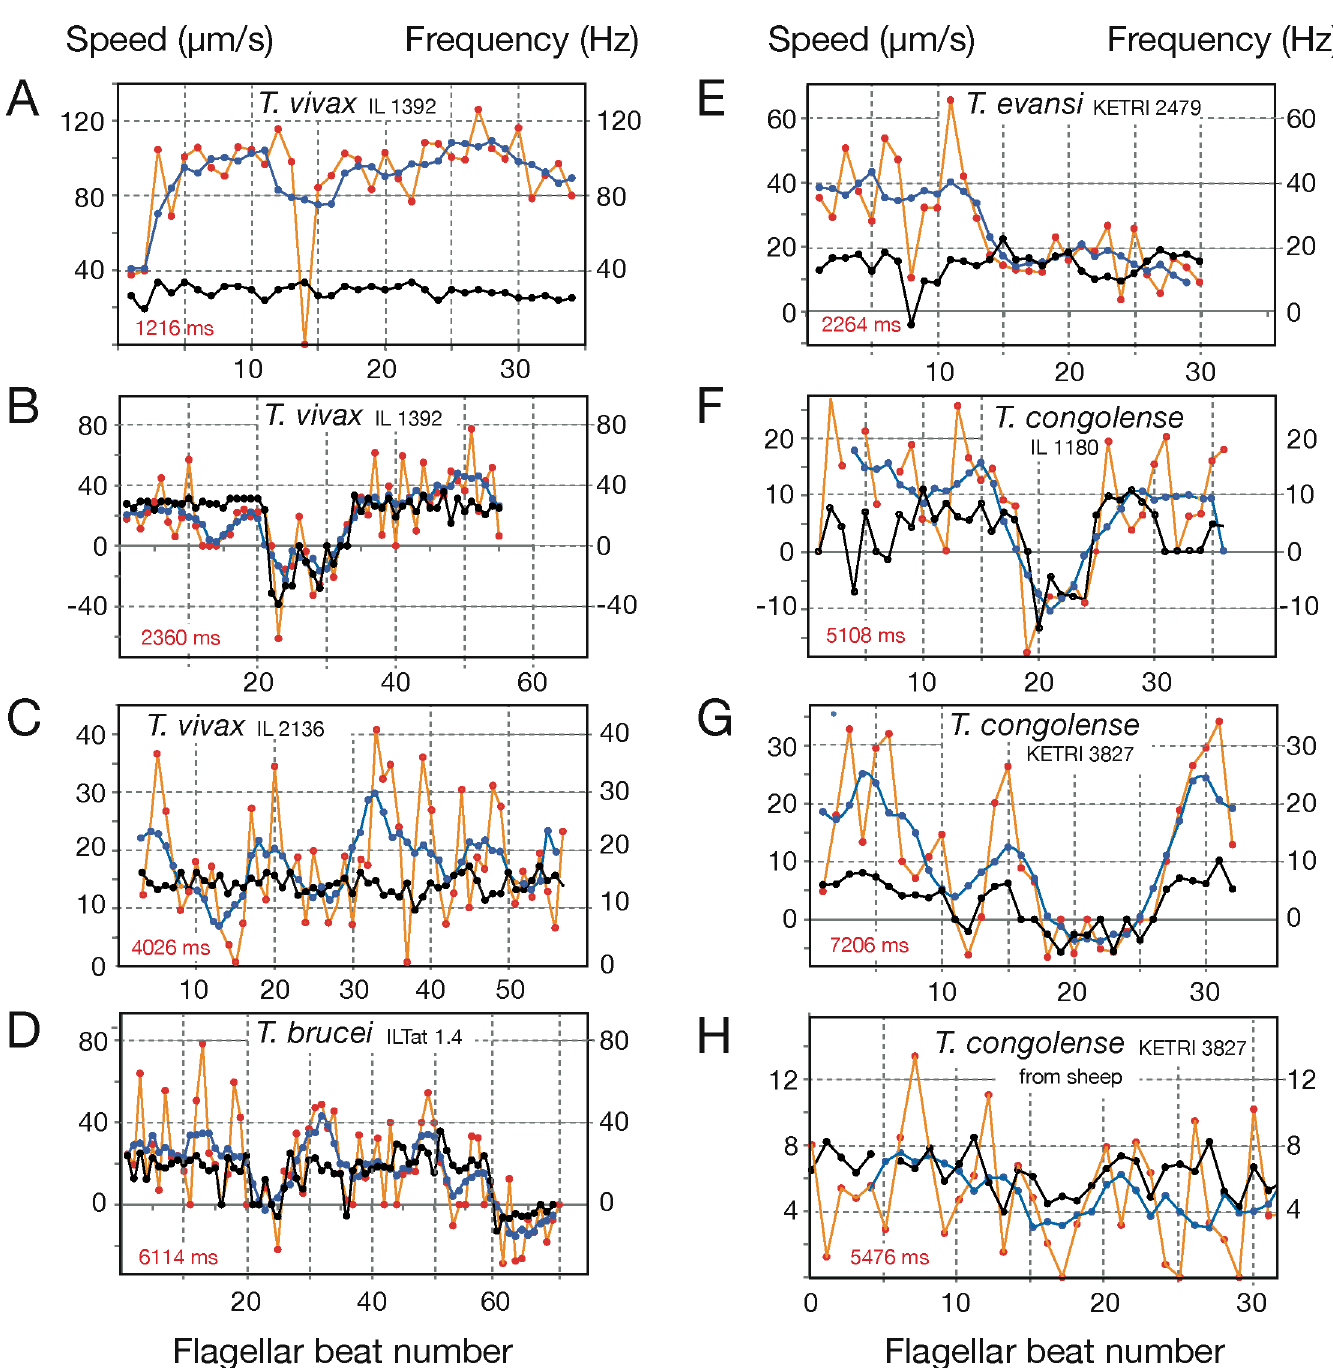
Fig 6. Extended single flagellar beat analysis of trypanosome motility in wet mouse blood. The graphs plot the velocities produced by single, consecutive flagellar beats (red dots), together with the beat frequency (black dots). The velocities, which were derived from measurement of the translocation of the posterior tip after each flagellar beat (white marks in S8 – S16 Videos), are averaged over 5 beats to generate the average directional speeds (blue dots). The red number is the overall observation period (ms). A) Fast type of a T . vivax IL 1392 persistent swimmer with a slim waveform (S8 Video), showing a 30 ms — stop upon mechanical hindrance. The flagellar tip directly hit an erythrocyte, whereupon the trypanosome stopped without flagellar beating being interrupted. Translocation resumed with the next flagellar beat. Note that neither beat frequency nor average velocity (blue line) were markedly changed by this stop. B) Example of a T . vivax IL 1392 normal waveform swimmer revealing a short ( < 1 second) period characterised by several base-to-tip beats, resulting in backward movement, i.e. negative speed (S9 Video). C) T . vivax IL 2136 exhibited lower beat frequencies than the IL 1392 strain (S10 Video). D) An intermediate T . brucei ILTat 1.4 swimmer exhibited two persistent swimming stretches interrupted by a short tumbling phase. This was